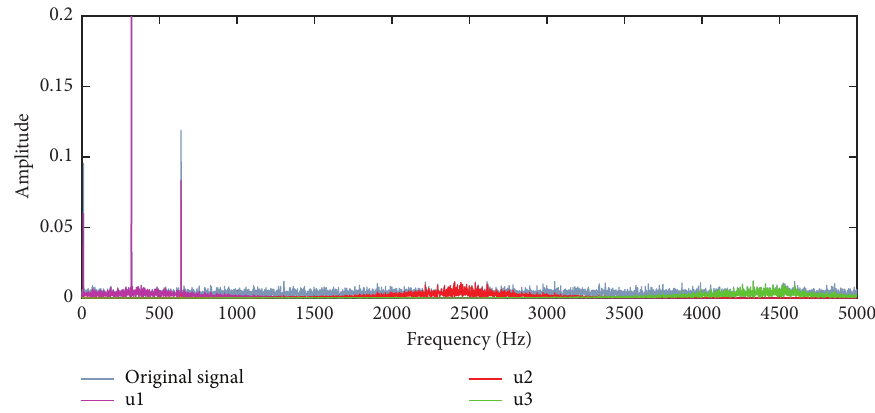
Figure 7: Simulated signals of case 1: the spectrum of each component based on IPAVMD.